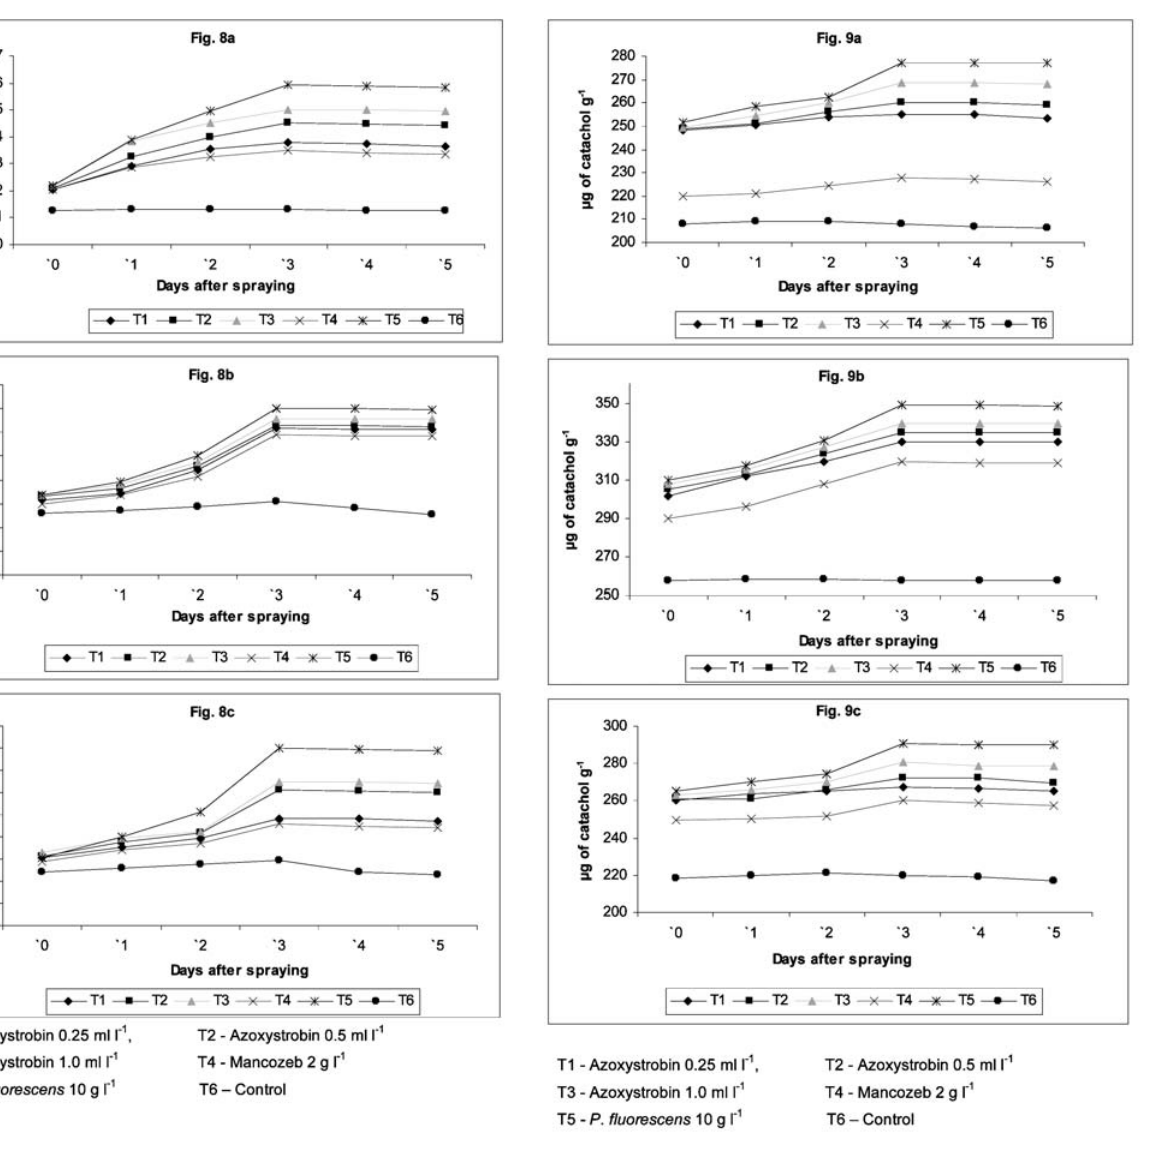
Fig. 8. Changes in catalase activity in cucumber plants: 8a uninoculated and treated with azoxystrobin and Pseu- domonas fl uorescens ; 8b. challenge-inoculation of downy mildew pathogen; 8c. challenge-inoculation of powdery mildew pathogen.